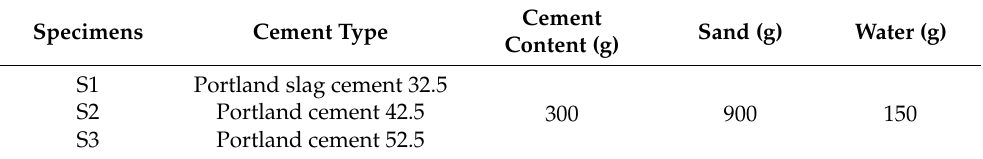
Figure 4. ( a ) Cement mortar specimens with embedded SAs; ( b ) Experimental monitoring system; ( c ) Schematic diagram of the monitoring system with four unit elements: the signal generation module, amplifier module, SAs, and oscilloscope. Table 2. Ingredient of the cement mortar specimens.